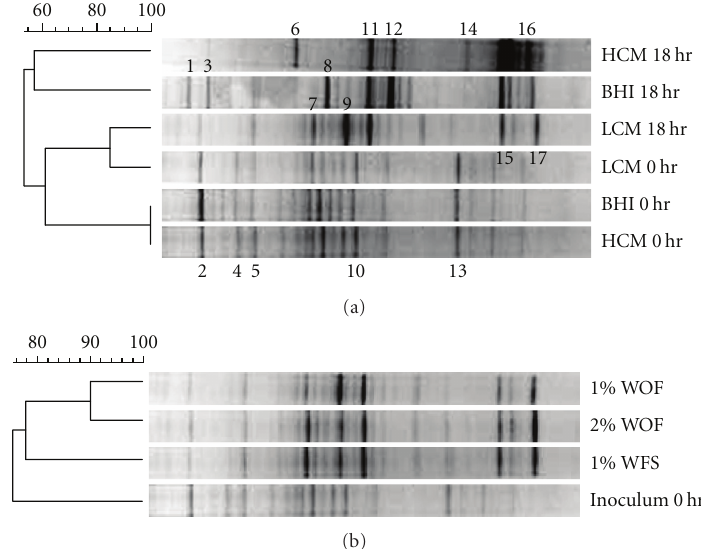
Figure 1: Dendrogram based on Dice coe ffi cient of the DGGE profiles of individual A. (a) The DGGE profiles of cultured sample from individual A in the low-concentration carbohydrate medium (LCM), high-concentration carbohydrate medium (HCM), and brain heart infusion medium (BHI) were compared at 0 hour and after 18 hours. The numbered bands were excised and sequenced. (b) The comparison of 1% inoculum with 1% fecal supernatant (1% WFS), 1% inoculum without 1% fecal supernatant (1% WOF), and 2% inoculum without fecal supernatant (2% WOF) after 18 hours growth time in individual A